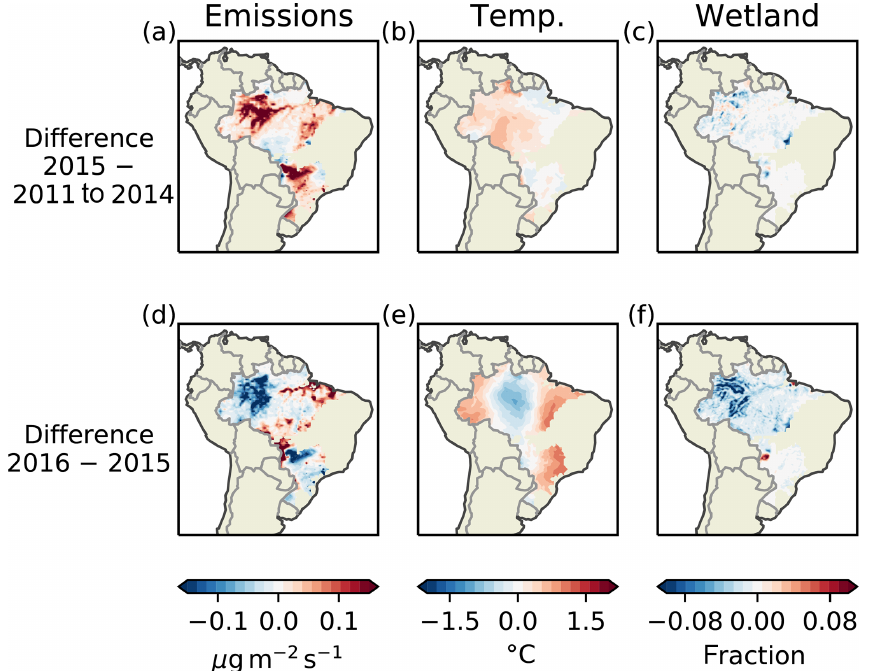
Figure 7. Differences during the wet season (FMA). (a–c) 2015 minus 2011–2014 average and (d–f) 2016 minus 2015. (a, d) CH 4 emissions, (b, e) surface temperature from the WFDEI meteorological dataset and (c, f) SWAMPS wetland fraction. All regions outside of the Brazilian Amazon and Pantanal have been masked for